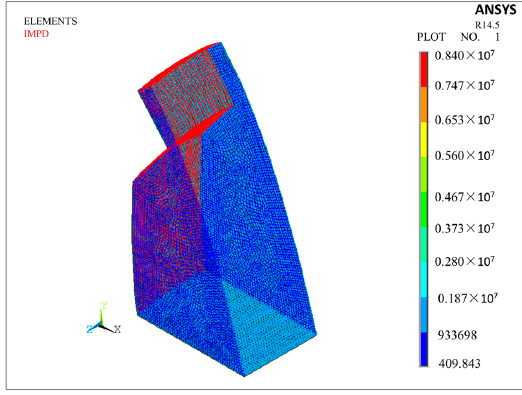
Figure 15. Cavity model of Condition 6.